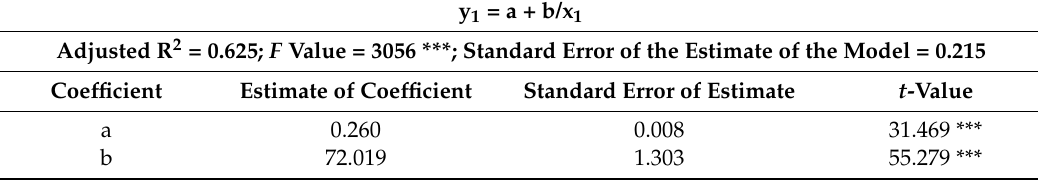
Figure 5. The consumption observations of stump treatment material as a function of the average stem size of softwood removal by cutting method, as well as the predicted consumption curve (cf. Table 2). Table 2. Regression model for the consumption (dm 3 m − 3 of softwood) of stump treatment material. y 1 = a + b/x